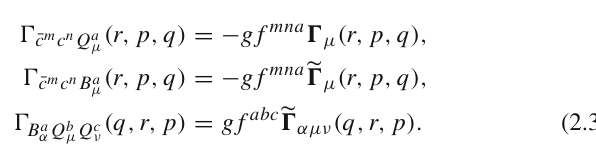
Fig. 1 Diagrammatic representations of the fully dressed three-point vertices. We show in the panels ( a ) the conventional ghost-gluon ver- tex (Qcc) ( b ) the background ghost-gluon vertex (B ¯ cc) and ( c ) the